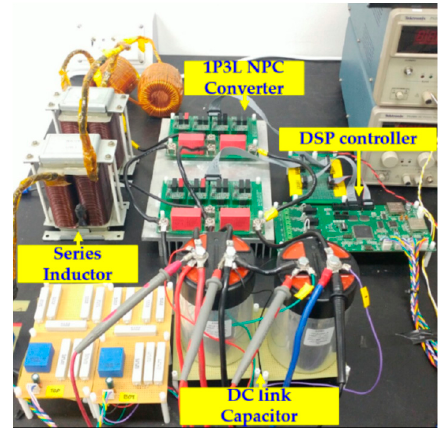
Figure 10. Hardware configuration for the dc-link capacitor voltage balancing test.